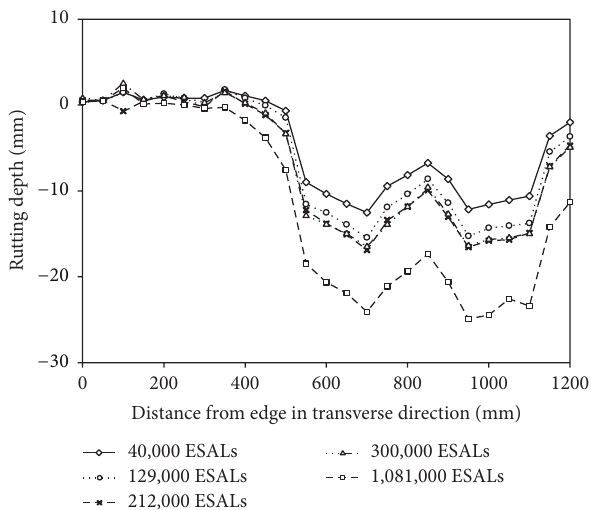
Figure 10: Difference in rutting depth between the APT data and the model.